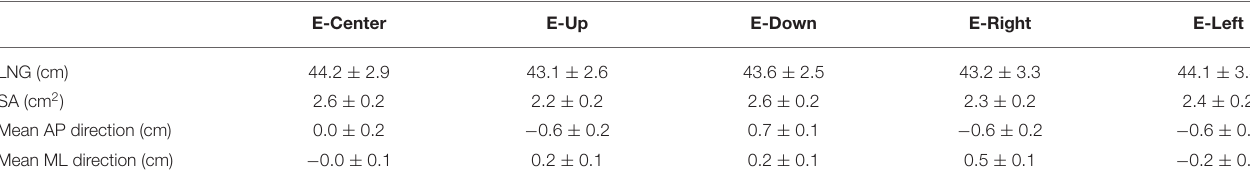
TABLE 1 | Results of CoP sway